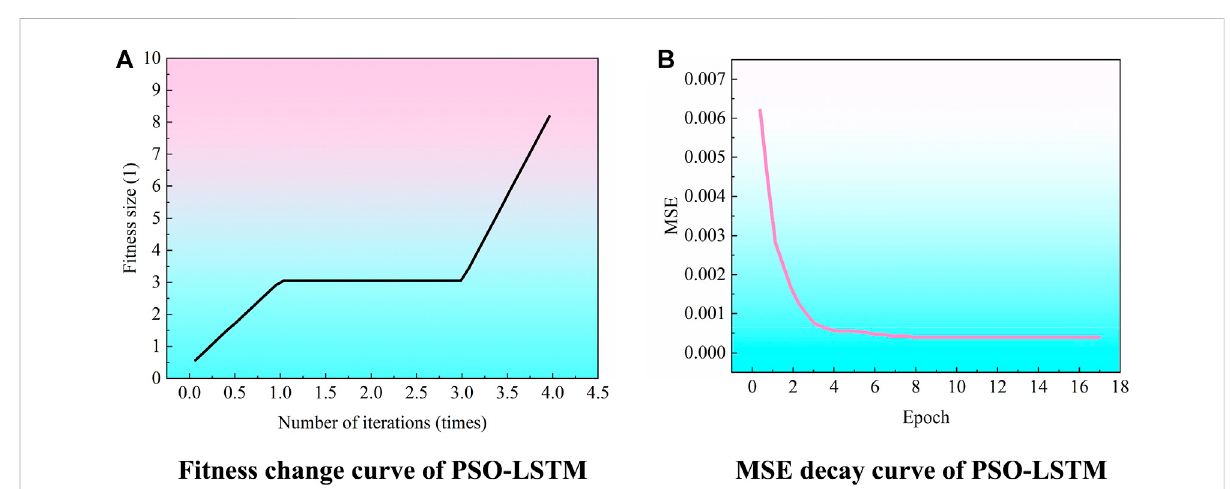
FIGURE 4 Optimization process curve (A) Fitness change curve of PSO-LSTM (B) MSE decay curve of PSO-LSTM.